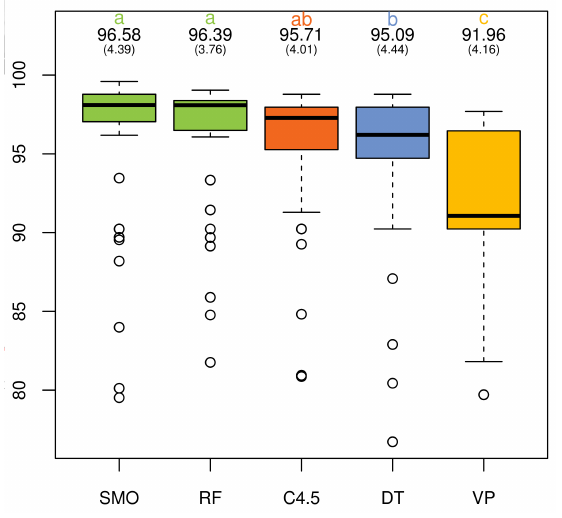
Figure 4. Classifiers’ global